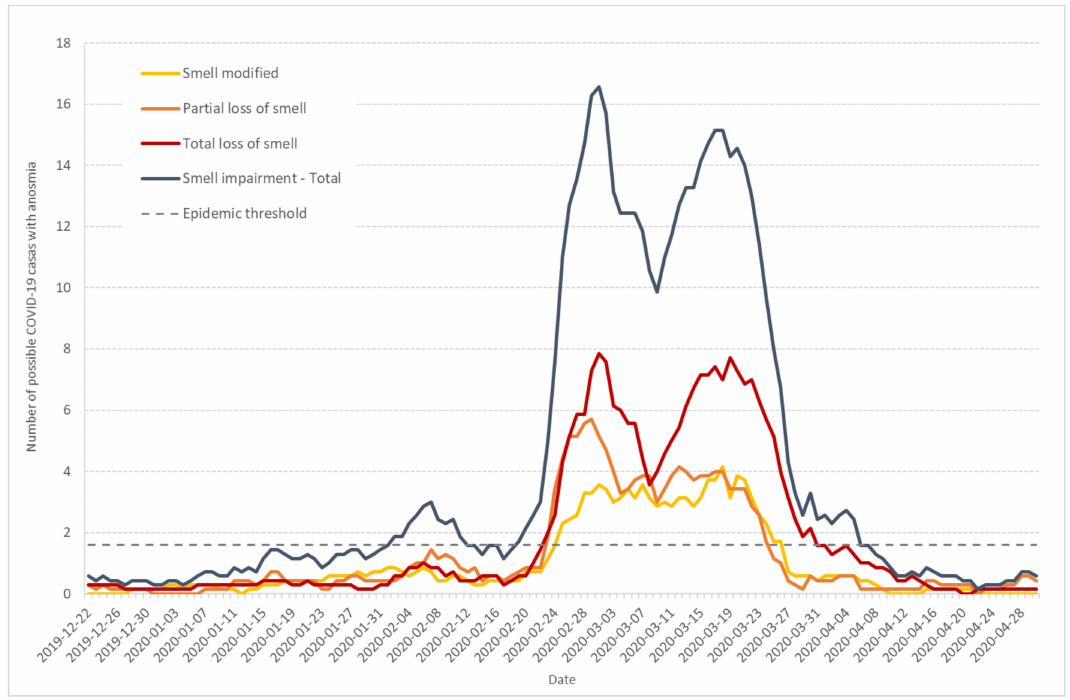
Figure 5. Seven-day moving average of daily incidence of possible COVID-19 cases that documented anosmia with intensities from 1 (modified smell) to 3 (total loss) (from survey data). The curves corresponding to partial (orange) and total (red) loss of smell display similar patterns, in particular a little increase at the end of January. The curve corresponding to smell modification (yellow) is less